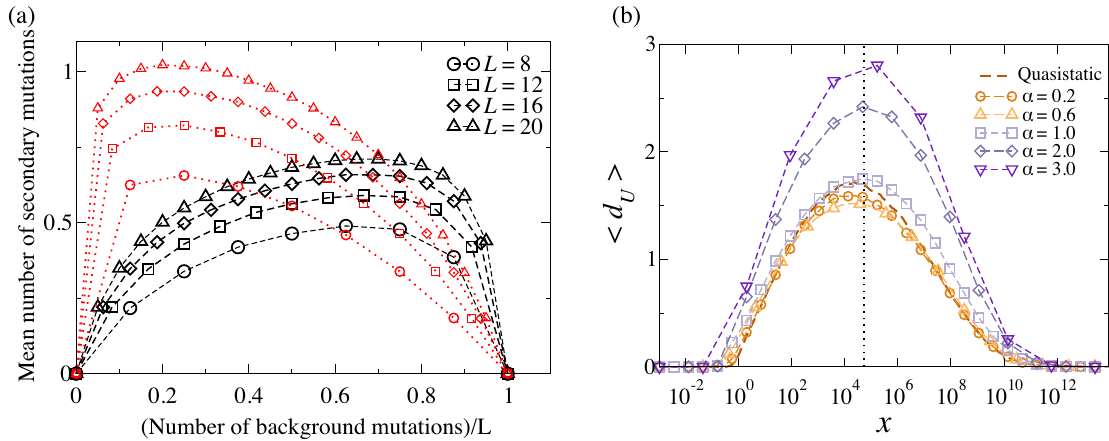
FIG. 8. Results on secondary mutations and genotypic reversibility. Simulations were conducted along the main hysteresis loop, and the mutation parameters were generated randomly as described in the main text and Appendix C. (a) The mean number of secondary mutations in an evolutionary transition under quasistatic driving as a function of the number of mutations in the originating background genotype. We used 10 5 realizations for averaging. Black symbols correspond to the U boundary and red to the D boundary. (b) Mean path irreversibility h d U ð x Þi is shown for various values of the driving rate α . Averages were performed over 10 4 realizations. The dashed black line corresponds to the quasistatic limit α → 0